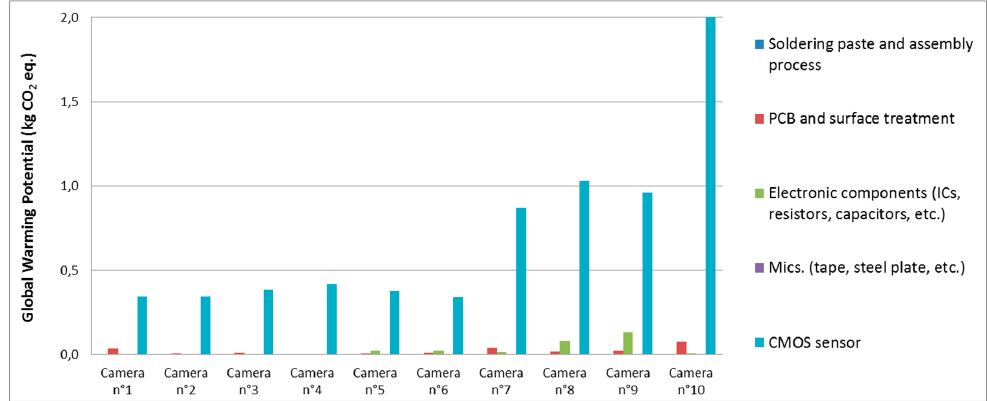
Figure 4. GWPI details for each camera electronic module.